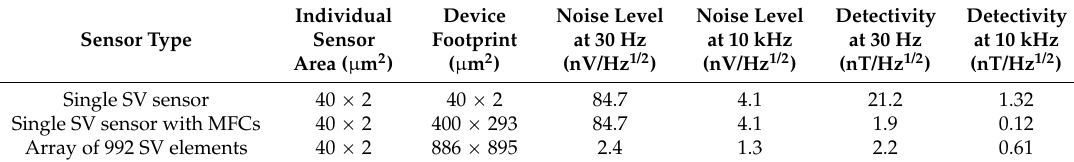
Table 1. Comparison of typical detection levels of a single SV element, obtained in low (10 Hz) and high (10 kHz) frequency range, with the obtained results upon the inclusion of MFCs and the patterning of a large array of series connected in parallel of